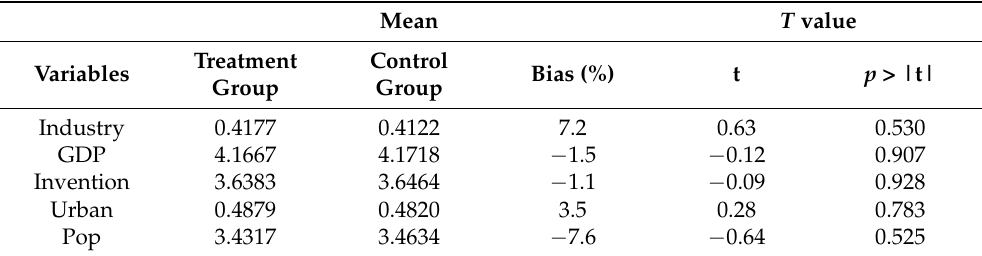
Table 4. PSM matching balance